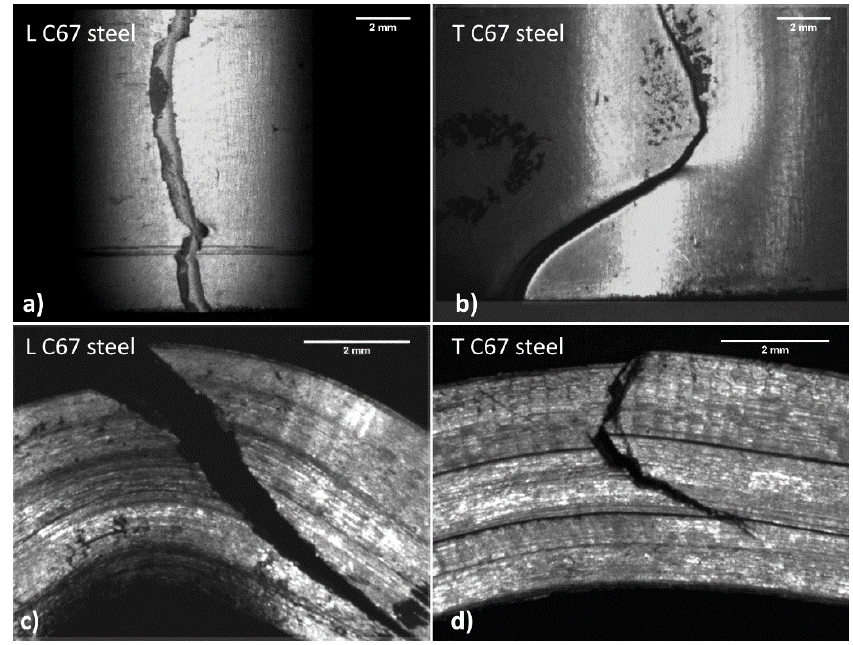
Figure 11. Both longitudinal ( a , c ) and transversal ( b , d ) C67 samples show a large crack across almost the entire resisting section.